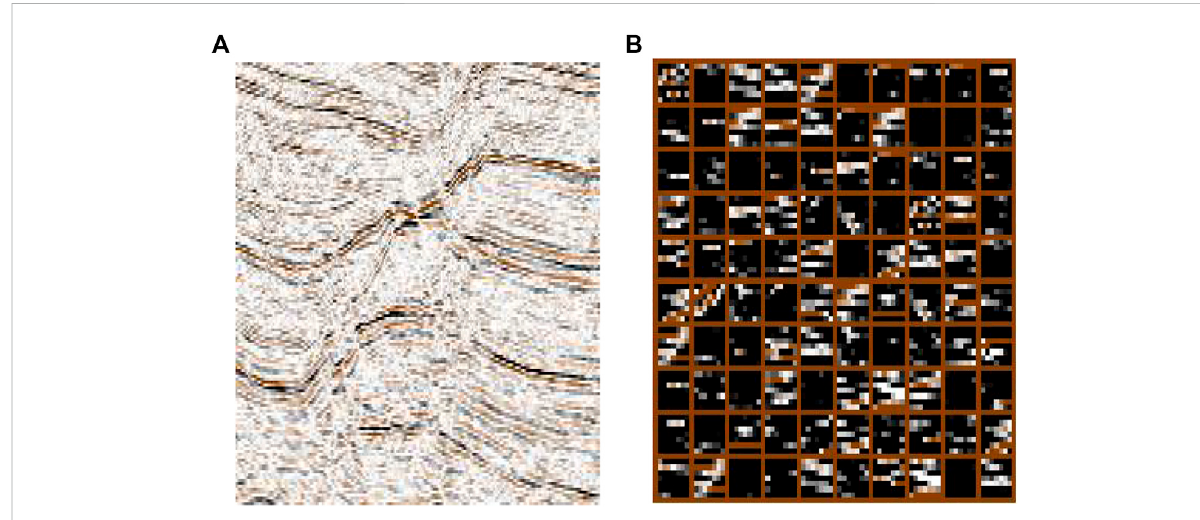
FIGURE 2 Training Set. (A) A seismic image; (B) Examples of non- fl at patches.